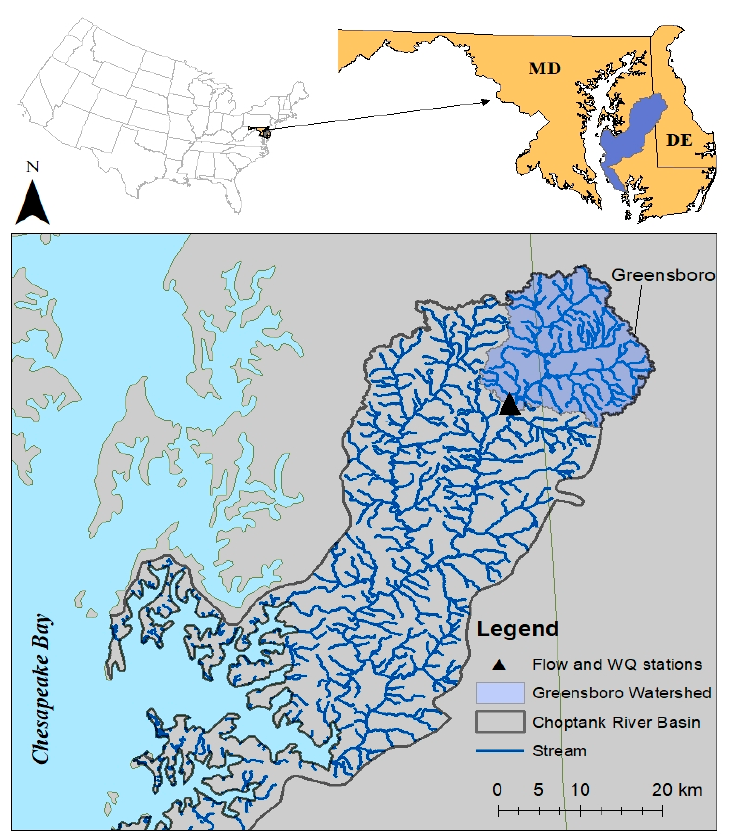
Figure 1. The location of the Greensboro watershed within the Choptank River basin.